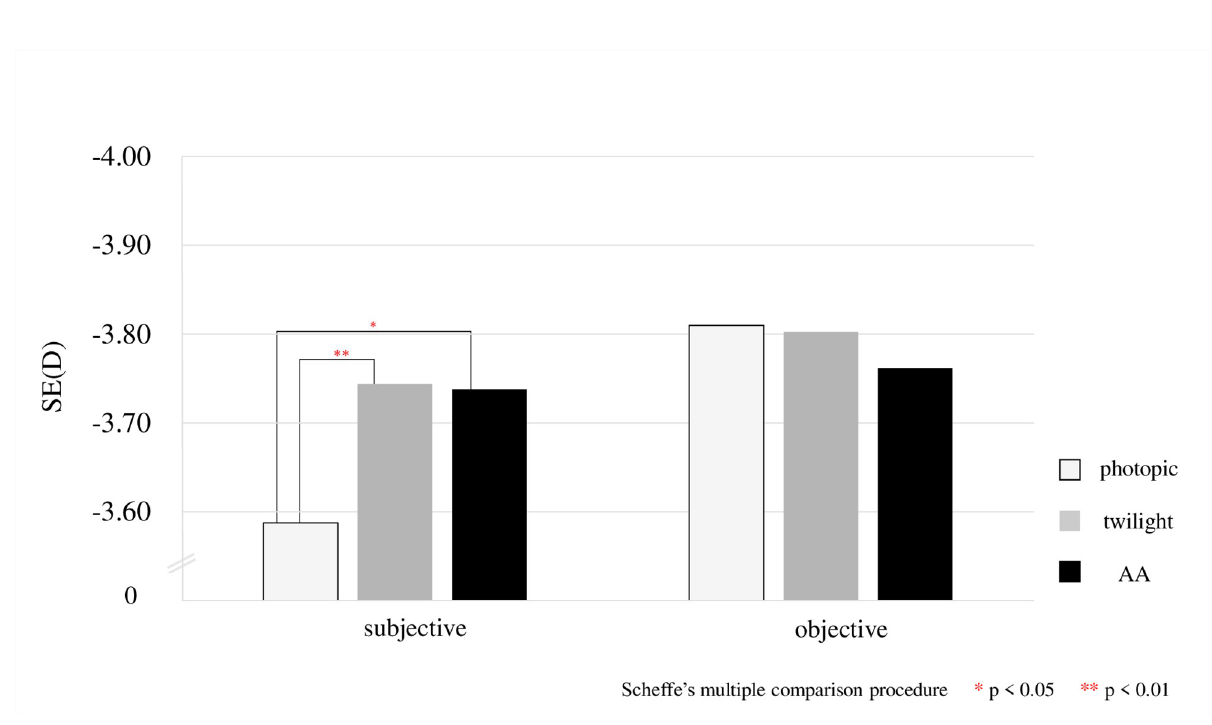
Fig 6. Enlarged comparison of the results shown in Fig 5.